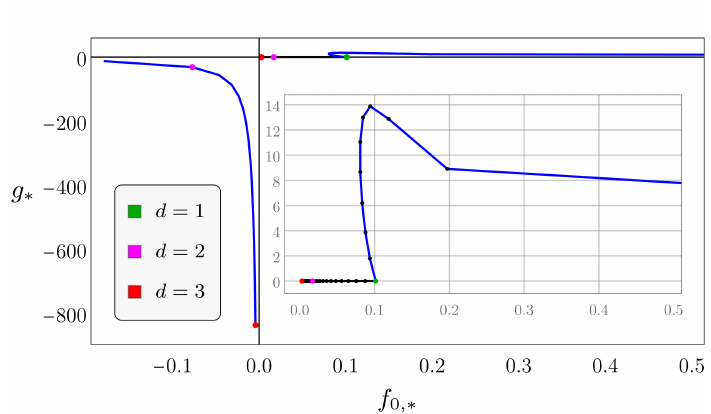
Figure 5 . Position of the GFP and NGFP for increasing values of the spatial dimension d and N = 2 . For d = 1 the two fixed points coincide (green dot). Increasing d , the GFP and NGFP split and move apart from each other. In d = 2 the two fixed points are depicted by magenta dots, while in d = 3 they are depicted by red dots. The smaller black dots in between are the two fixed points for non-integer dimensions. The trajectories drawn by the Gaussian and non-Gaussian fixed points for increasing values of d are shown as black and blue lines respectively. As can be seen from this figure, for N = 2 the NGFP in d = 1 + (cid:15) and d = 3 dimensions are not continuously connected: there exists a critical dimension d 2 beyond which g vanishes and becomes negative, while crit < ∗ f 0 , ∗ diverges at d crit and re-emerges at d > d crit with arbitrarily large and negative values.